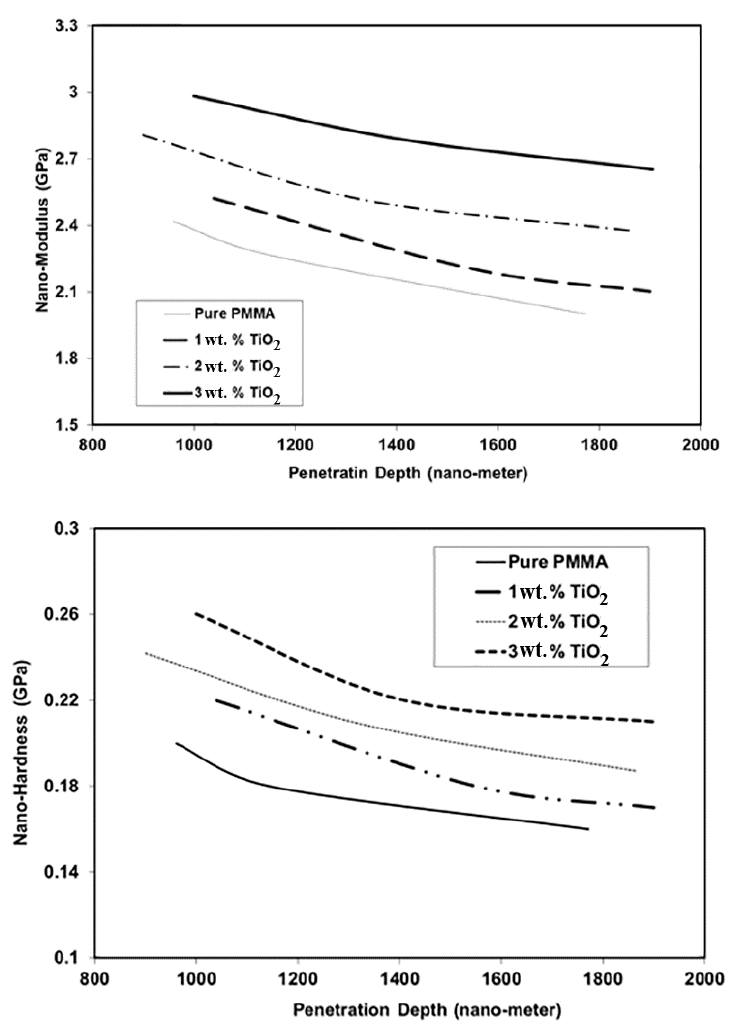
Figure 4. Nanomechanical properties of PMMA and its nanocomposites at different penetration depths for 0wt, 1 wt. %, 2 wt. %, and 3 wt. % TiO 2 NPs.